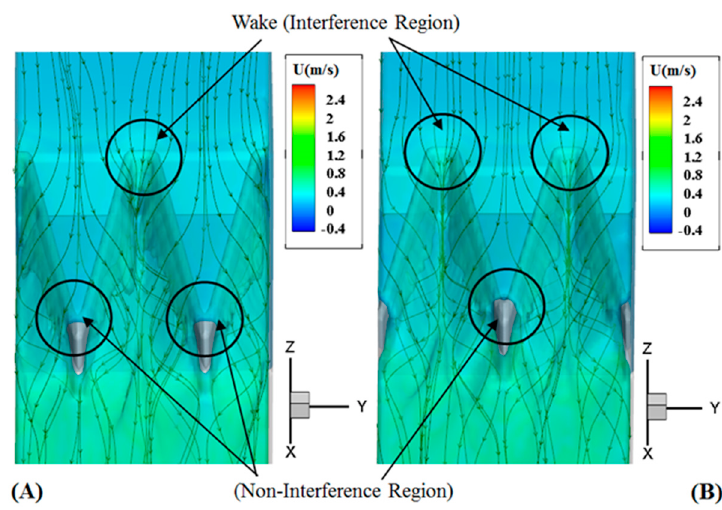
Figure 8. The collision of nappes from adjacent sidewalls of TTLW in ( A ) normal orientation and ( B ) inverse orientation.